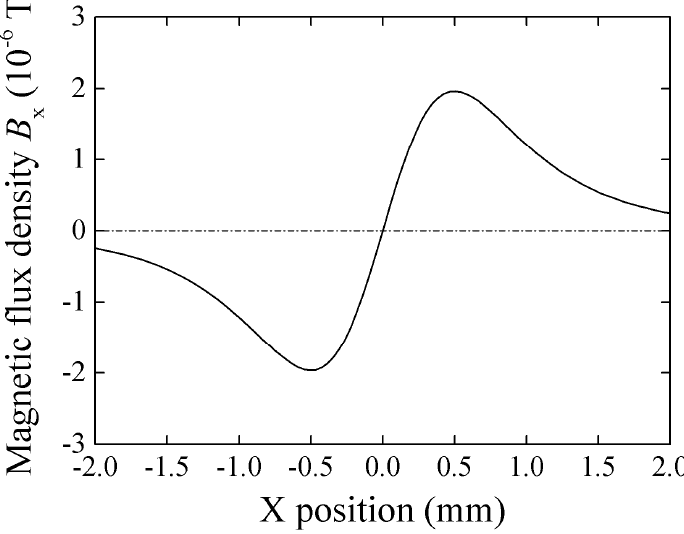
Figure 3. Variation of magnetic flux density in X-direction, B x , as a function of X-position [21].